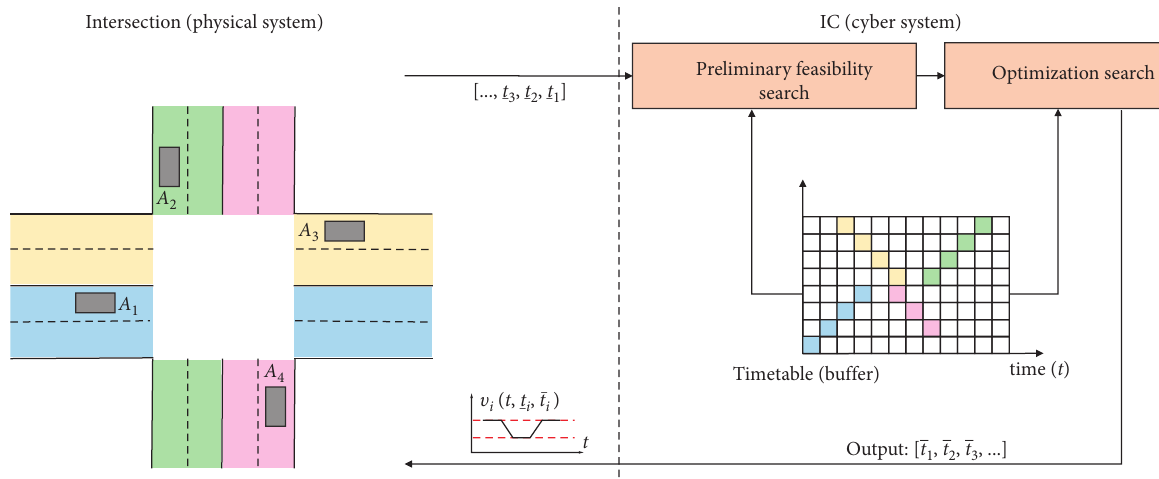
Figure 3: Block diagram of the IC. The IC receives the entry times of the vehicles when they enter the intersection. The preliminary feasibility search procedure generates a set of initial conditions for the optimization search. The output of the optimization search is the arrival time of each vehicle to the IR, which is translated into a velocity profile.